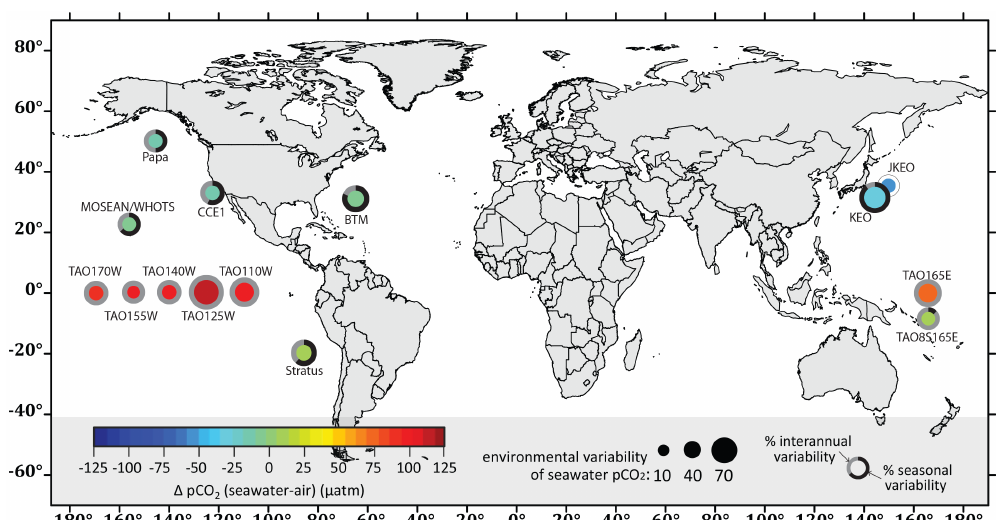
Figure 3. Location of open-ocean moorings in the MAPCO 2 data set. Inner circle color illustrates the mean 1p CO 2 of the finalized data at that location. Inner circle size is relative to the environmental variability in the time series defined here as the standard deviation of seawater p CO 2 values. The outer ring shows the proportion of environmental variability in seawater p CO 2 due to the seasonal cycle (black) and interannual variability (gray). Seasonal variability is defined as the mean seasonal peak amplitude, and interannual variability is the mean 1 of annual mean values. Seasonal and interannual variability cannot be quantified at JKEO with a time series of < 1 year and is represented here by an outer ring with no